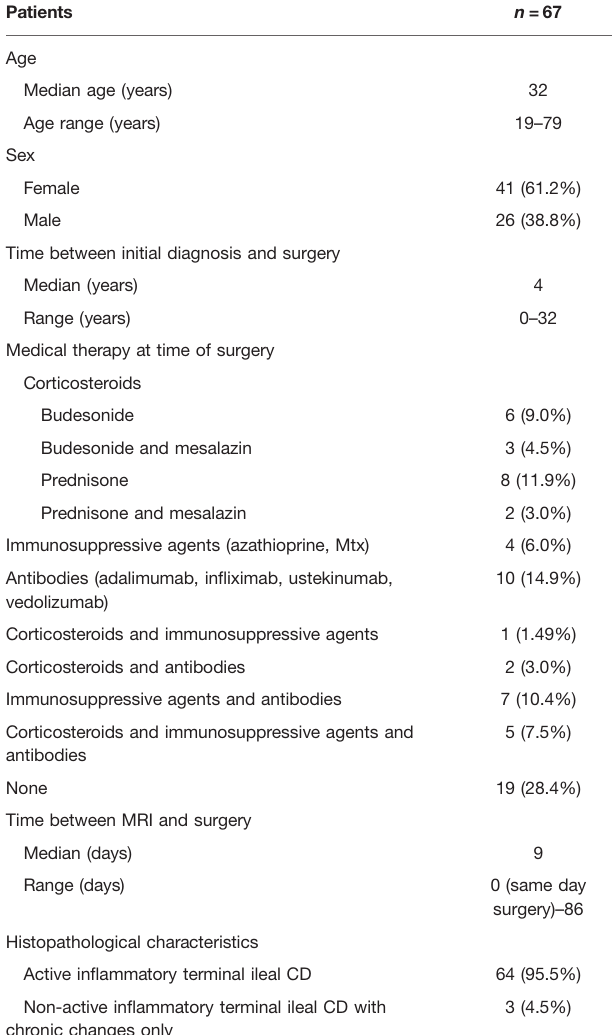
TABLE 1 | Demographic and clinical characteristics of the patient population investigated.